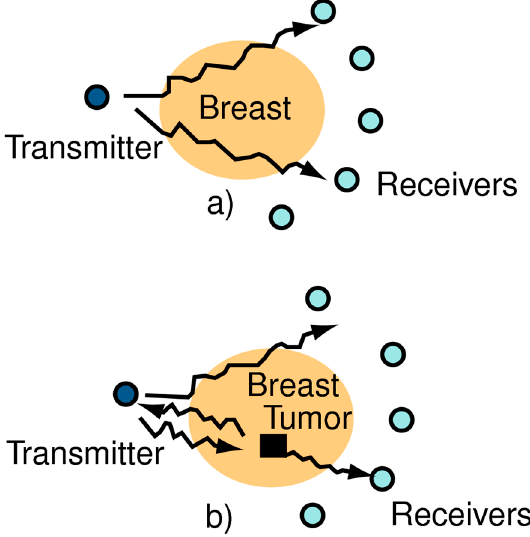
Figure 1. Basic microwave imaging problem ( a ) Reflected waves from breast without a tumor ( b ) Reflected waves from breast with a tumor. Changes indicate differences from tumor-free breast [15].